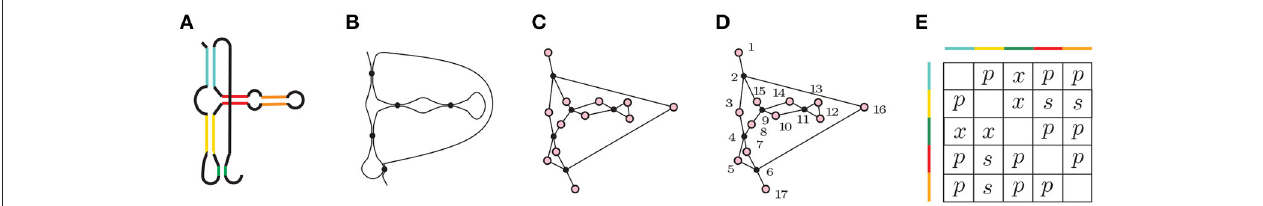
FIGURE 5 | (A) A depiction of Hammerhead Ribozyme and (B) a coarse grained schematic of the molecule. (C) The simplicial complex that represents Hammerhead Ribozyme. (D) Filter function of Hammerhead Ribozyme. Voids of extended type in the extended persistence are represented by a multiset